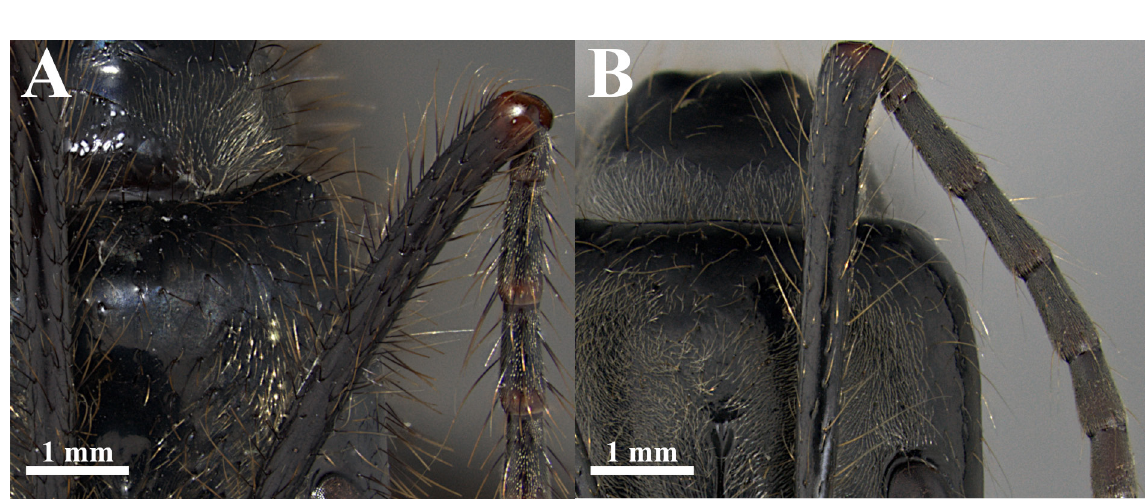
Fig. 5. Detail of pilosity types. A . Dinoponera hispida Lenhart, Dash & Mackay, 2013. B . D. mutica Emery, 1901.